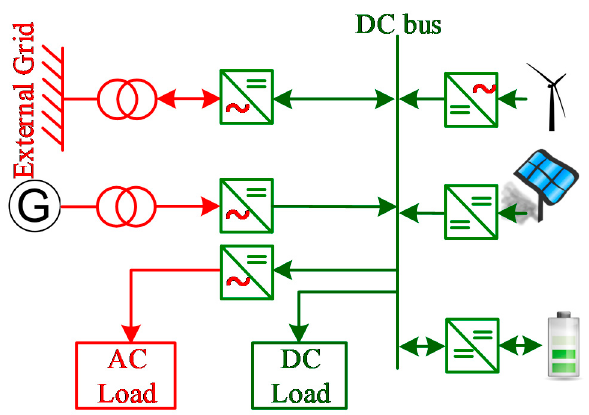
Figure 7. DC architecture for smart grids.